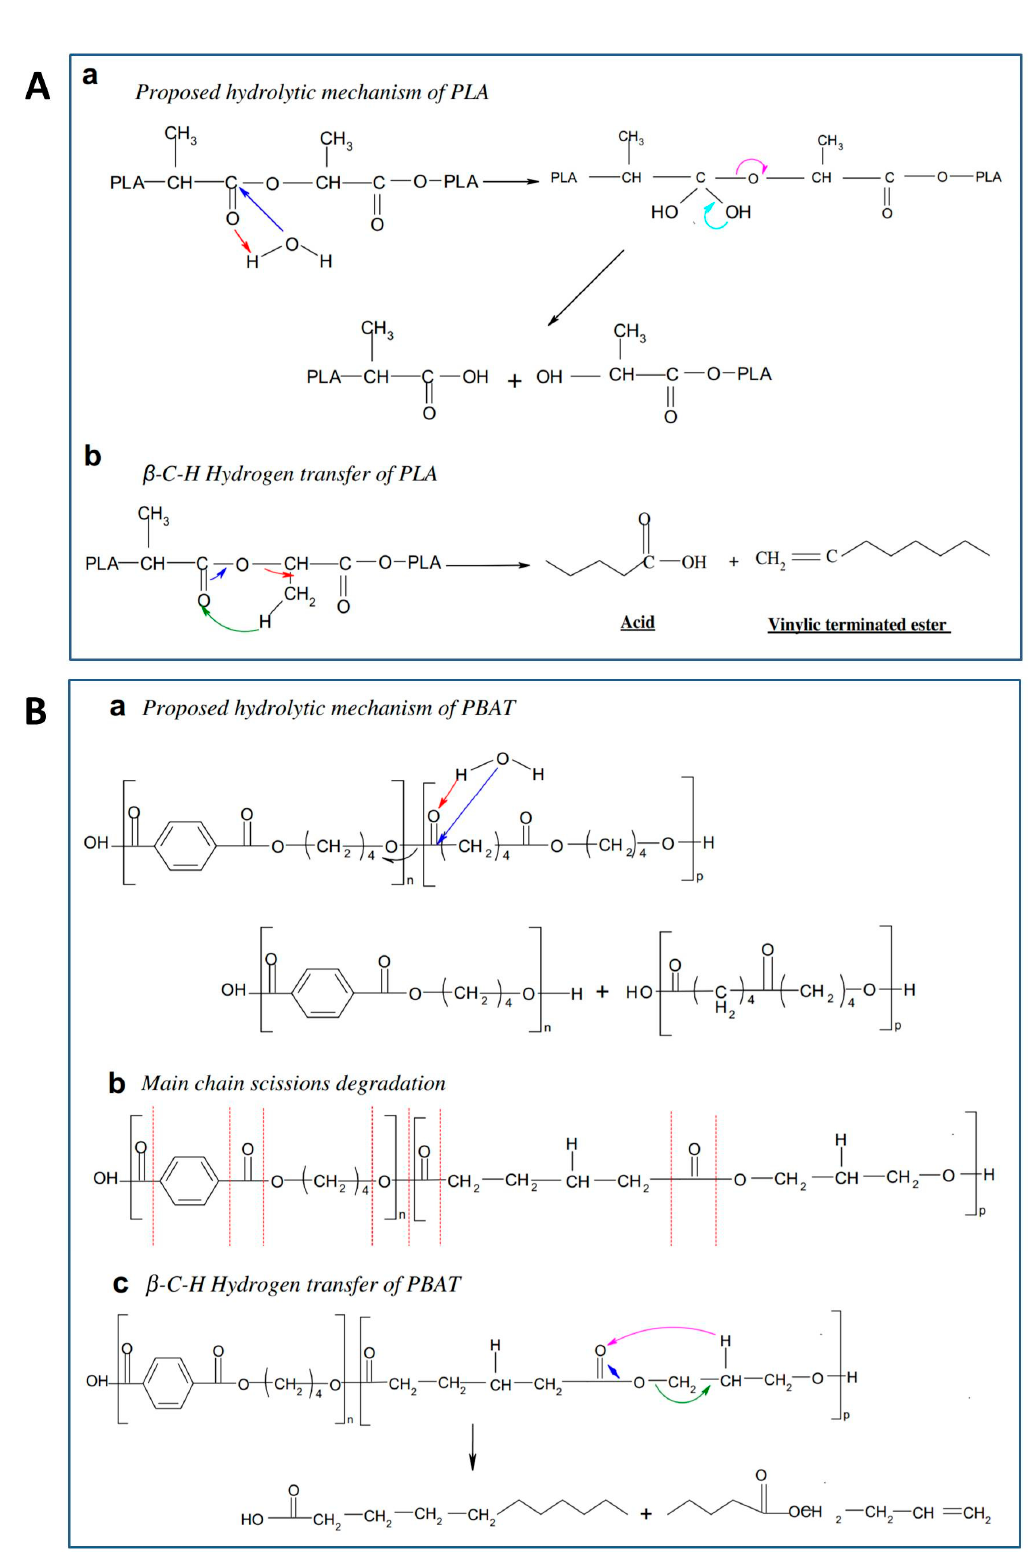
Figure 1. Schematics of hydrolytic degradation mechanisms of the most widespread biodegradable polyesters: ( A ) poly-lactic acid (PLA), ( B ) poly-butylene adipate-co-terephthalate (PBAT) [21]. (reproduced with permission from Elsevier).